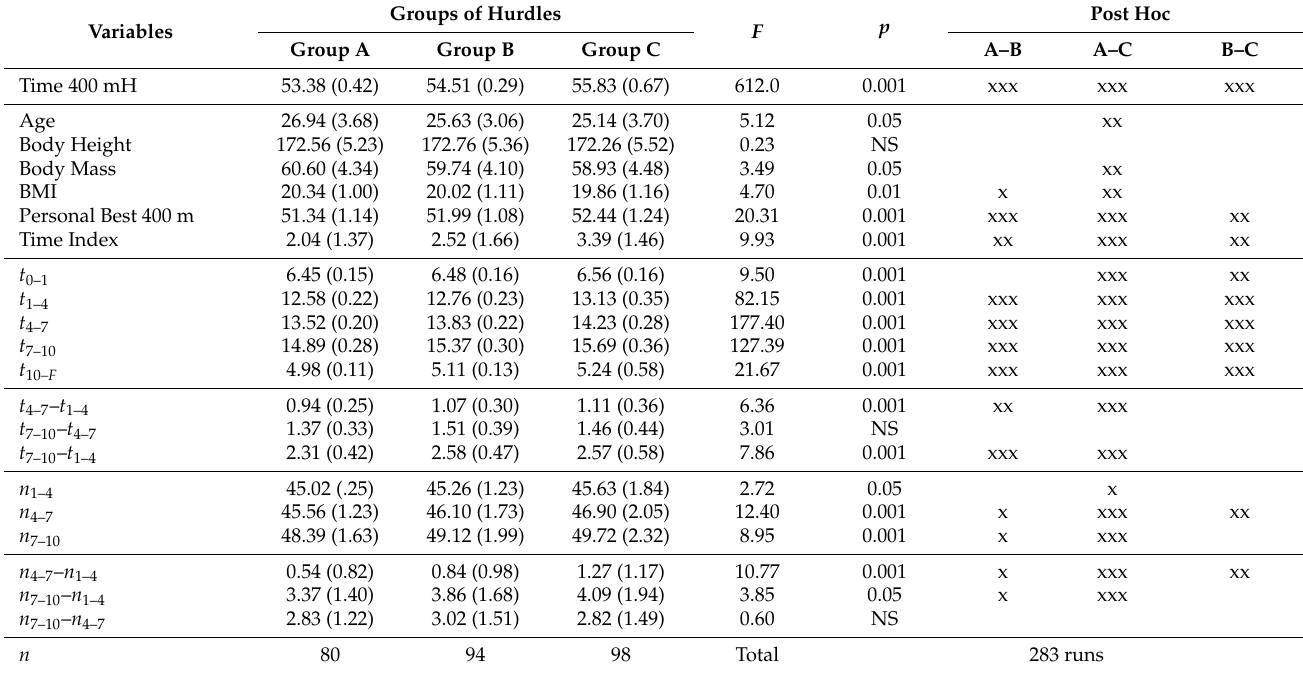
Table 9. Mean and SD values of variables in sports level categories and results of ANOVA analysis with F and p -values. Post hoc statistical significance for detailed